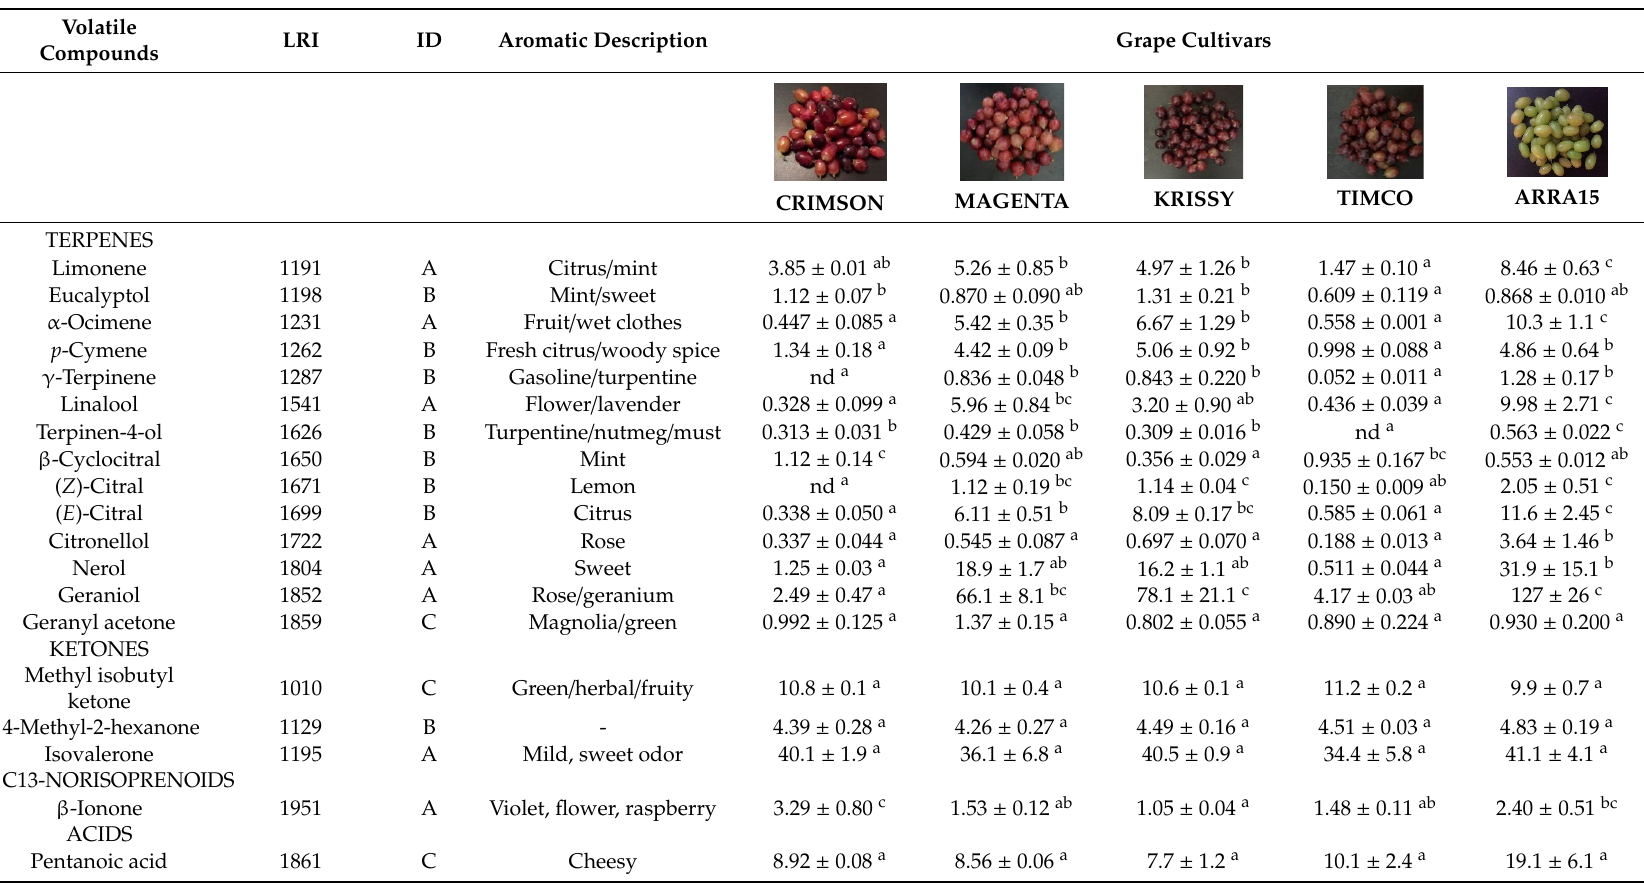
Table 1. Volatile compounds determined in the grape cultivars analyzed at their commercial maturity (D4). Data are expressed in relative area (abundance) with respect to the internal standard.